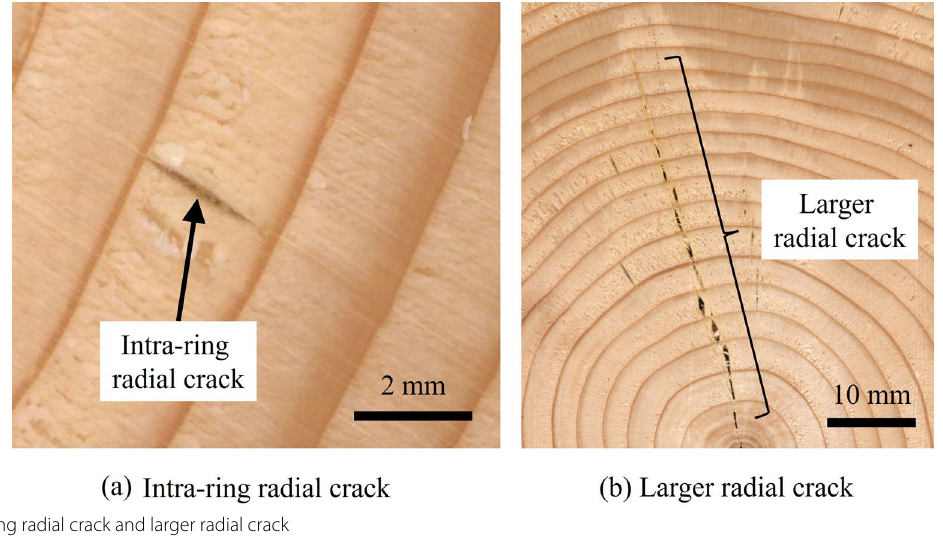
Fig. 2 Intra-ring radial crack and larger radial crack